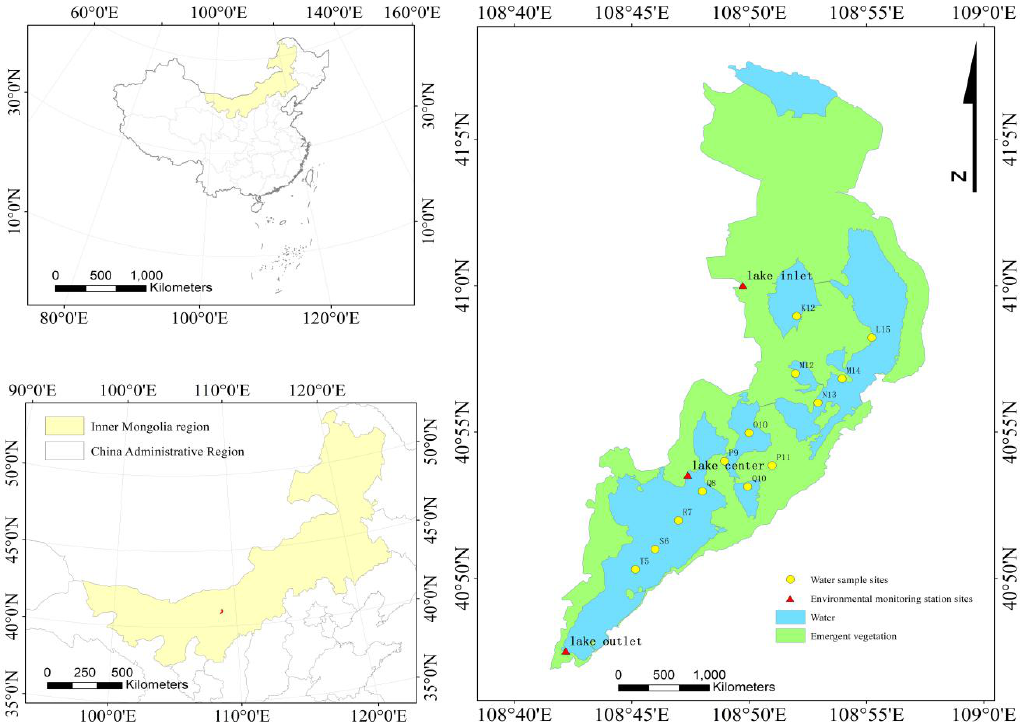
Figure 1. Geographical location of the sampling sites in Lake Ulansuhai.